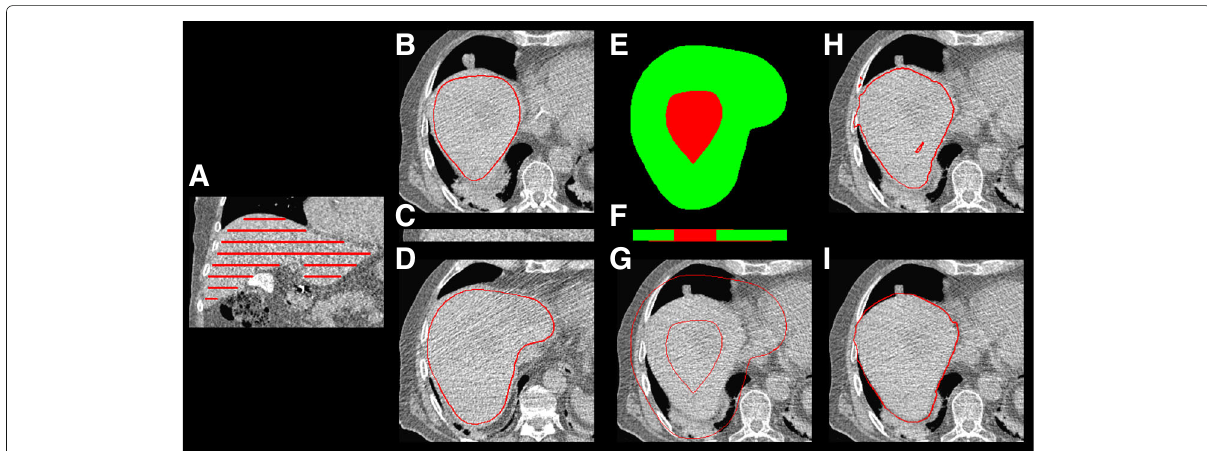
Fig. 3 Semi-automatic liver segmentation steps (patient ID BI01 from training set in our database), a manual liver segmentation in every 15th slices, c a layer and b , d transverse slice of the upper and the lower plane of a sample layer and their manual segmentation, e , f the layer region growing seed (red) and mask (green), g a slice in the middle of the layer and its seed and mask, h initial region growing result, and i final